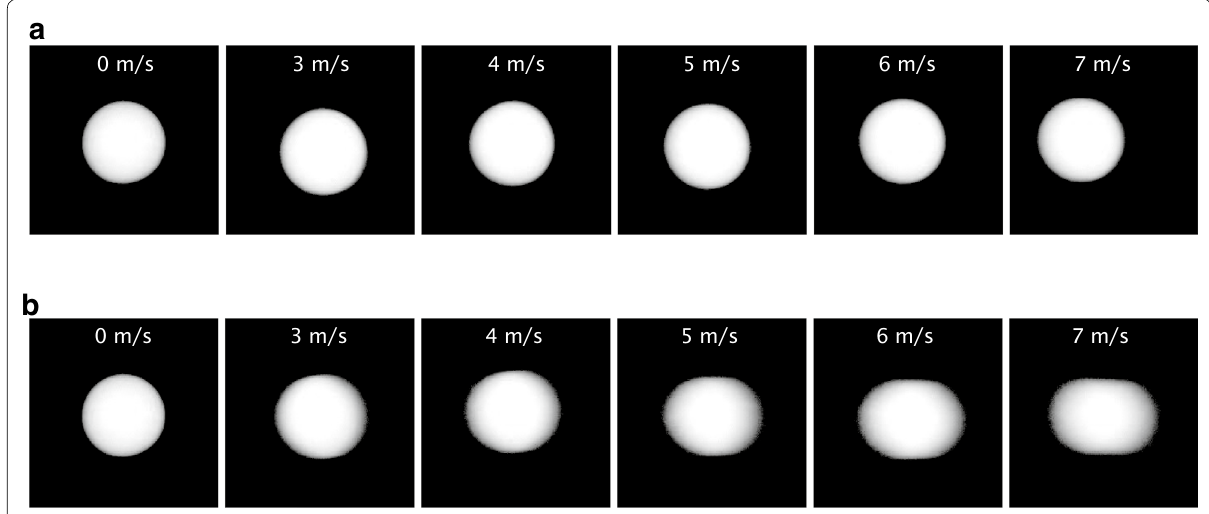
Fig. 16 Images captured when the table tennis ball was thrown in the horizontal direction. a With tracking (IT). b Without tracking